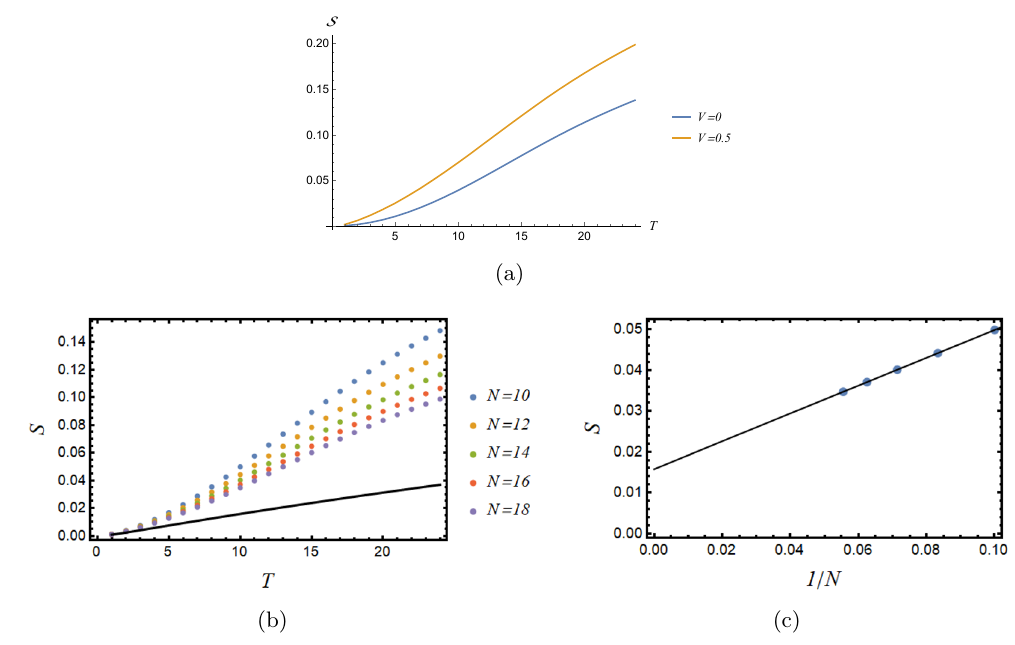
Figure 9 . (a) The time evolution of the Rényi entropy per Majorana fermion with and without coupling to the chaotic Majorana for N = 18 . (b) The time evolution of Rényi entropy per Majorana fermion for N = 10 , . . . , 18 and V = 0 . 5 are shown by dots and its extrapolation to N → ∞ is the black line. The parameters are β = 0 , J = 1 and w = 10 . We discretize T by 40 points. (c) An example of the extrapolation procedure. The plot is shown for T = 10